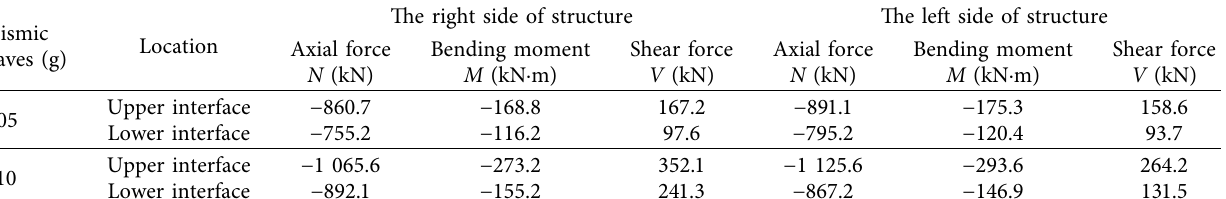
Table 2: Internal forces of the tunnel structure.